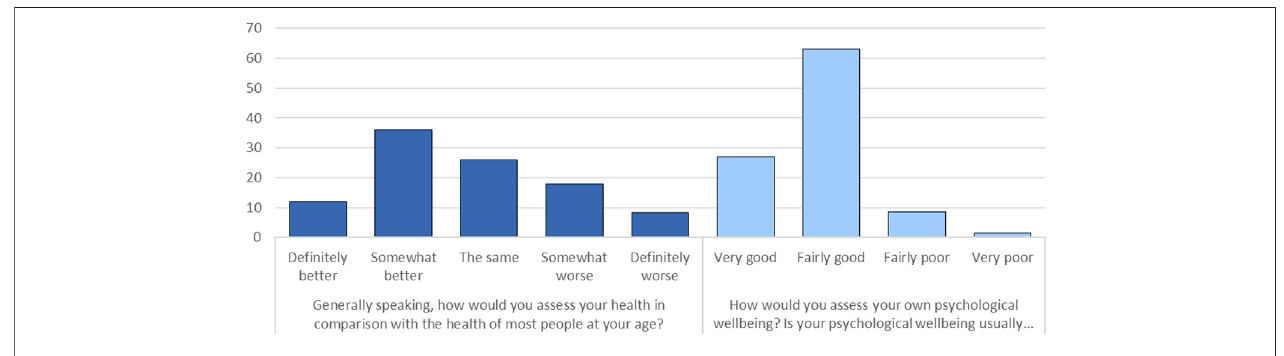
FIGURE 1 | Self-reported health and psychological wellbeing in the analyzed sample,